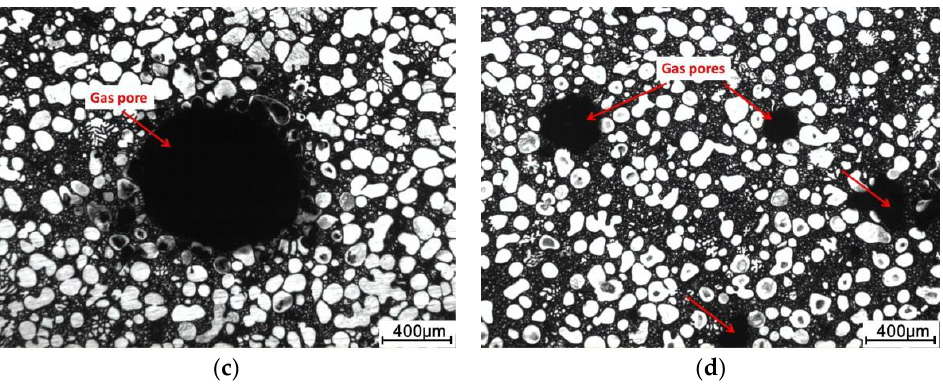
Figure 12. Internal defects in the microstructure of rheo-diecast AZ31 alloy. ( a ) Cold shut; ( b ) crack; ( c , d ) gas porosity.